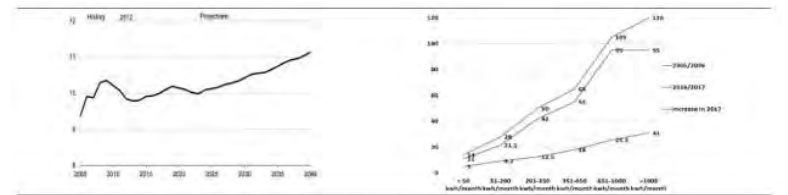
Figure 3. Left: Average residential sector electricity prices in 2012 and projection to 2040 in United States of America (cents per kilowatthour). (“AEO2014 results and status updates for the AEO2015,” 2014). Right: Energy Prices Rise (Tarrifs Piaster/KWh) residential sector in Egypt according to 2005-2006 and 2016-2017 annual reports (“Egyptian electricity holding company annual